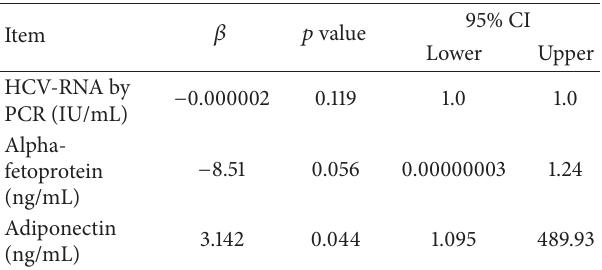
Table 3: Multiple regression analysis for pretreatment predictors of treatment